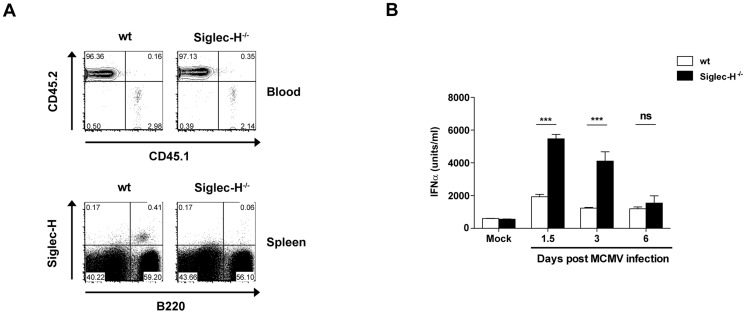
IFNα serum levels are elevated in the absence of Siglec-H upon MCMV infection.Lethally irradiated CD45.1+ wt mice were reconstituted with CD45.2+ wt or Siglec-H−/− BM followed by infection with 5×104 PFU of wt MCMV. (A) FACS plots show efficient donor reconstitution in the blood eight weeks after BM transfer (upper panel). Siglec-H and B220 stainings of splenocytes confirm the lack of Siglec-H expression in wt mice reconstituted with Siglec-H−/− BM (lower panel). (B) The kinetics of serum IFNα levels 1.5, 3 and 6 days p.i. compared between Siglec-H−/− and wt mice, n = 4–5 mice/group. Data are from one of two individual experiments with similar results. ns = not significant ***p<0.001, Students t-test.